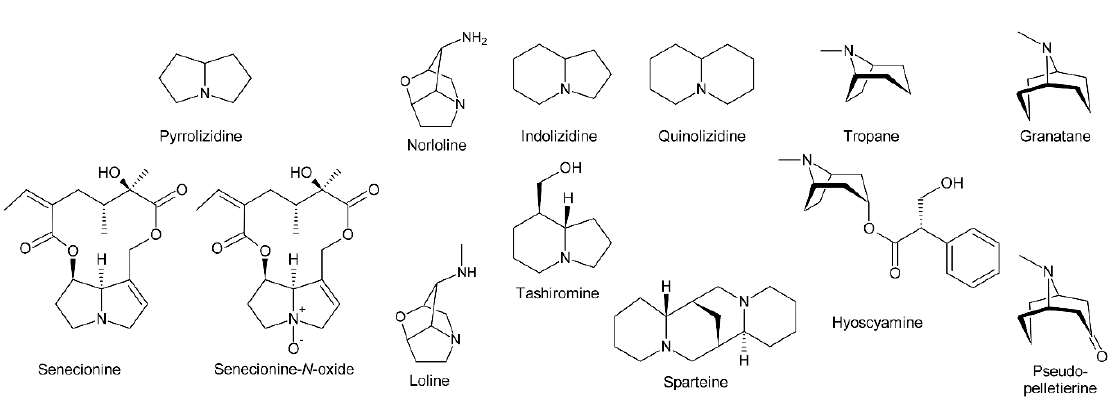
Figure 1. Core structures and examples for pyrrolizidine, loline, indolizidine, quinolizidine, tropane and granatane alkaloids. In contrast to the other alkaloids pyrrolizidine alkaloids appear mainly as N -oxides, as shown for the example of senecionine- N -oxide.